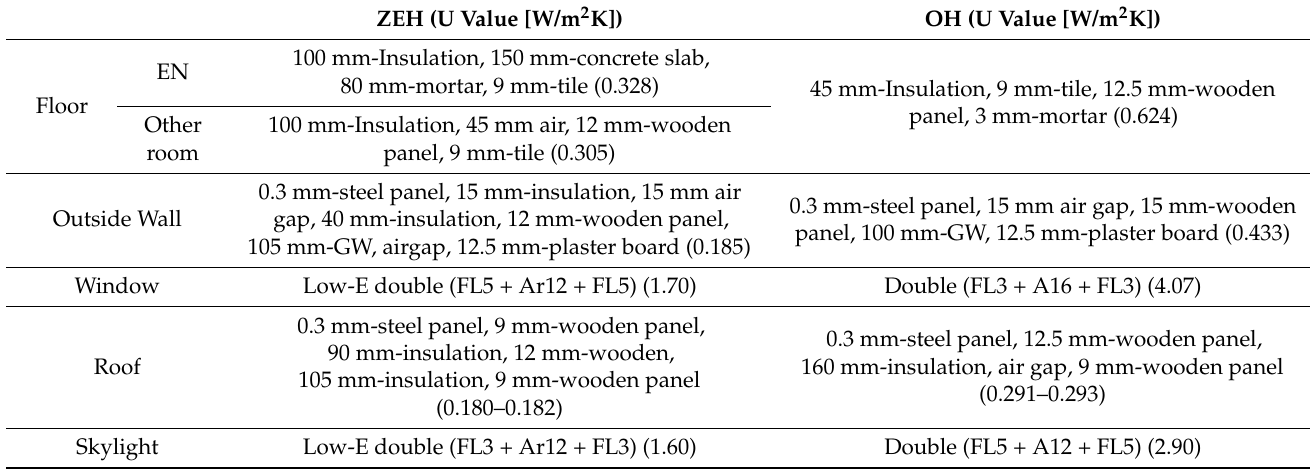
Table 3. Envelope specifications.